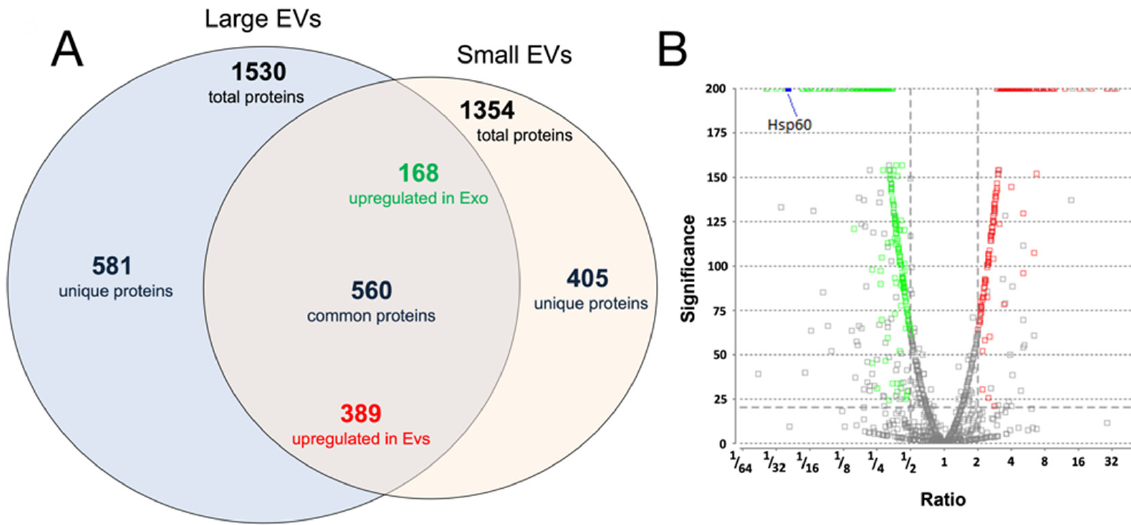
Figure 4. ( A ) Venn diagram showing the identified proteins (unique, common, and up-/down-regulated) between large extracellular vesicles (EVs) and small EVs. ( B ) Volcano plot of significant proteins differentially expressed between large EVs and small EVs. The X axis represents the fold change of differentially accumulated proteins represented with the ratio (large/small EVs), and the Y axis represents the corresponding significance. Fold change ≥ 2 and t -test with a p < 0.05 were set as the significance threshold for differential expression. Green represents downregulated proteins, and red represents upregulated proteins (large EVs/small EVs).